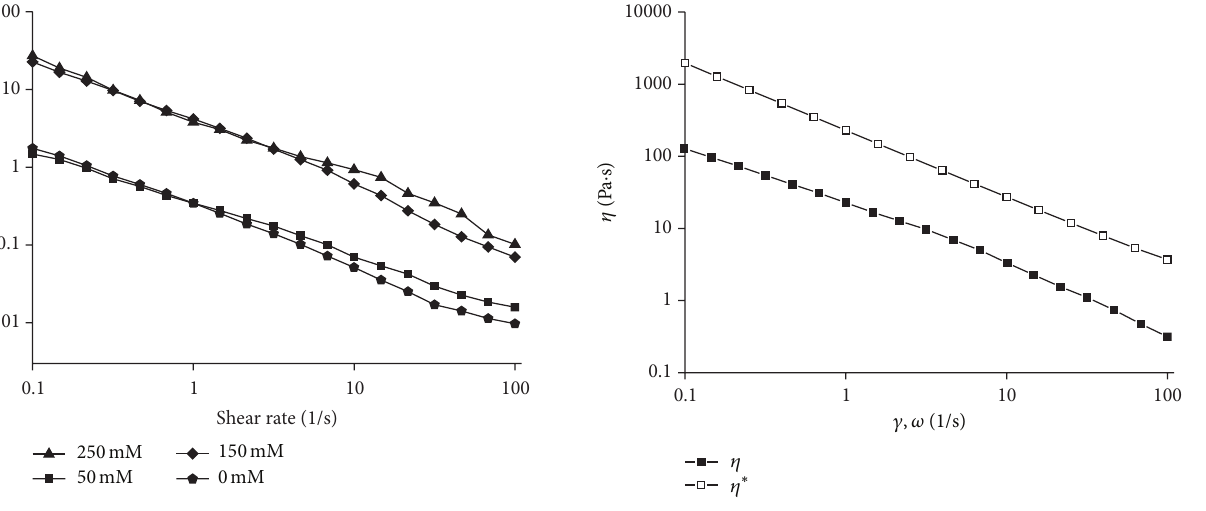
Figure 4: Cox-Merz plot of polysaccharide of 10% solution at 25 ∘ C ( X - 𝜂 ; ◼ - 𝜂 ∗